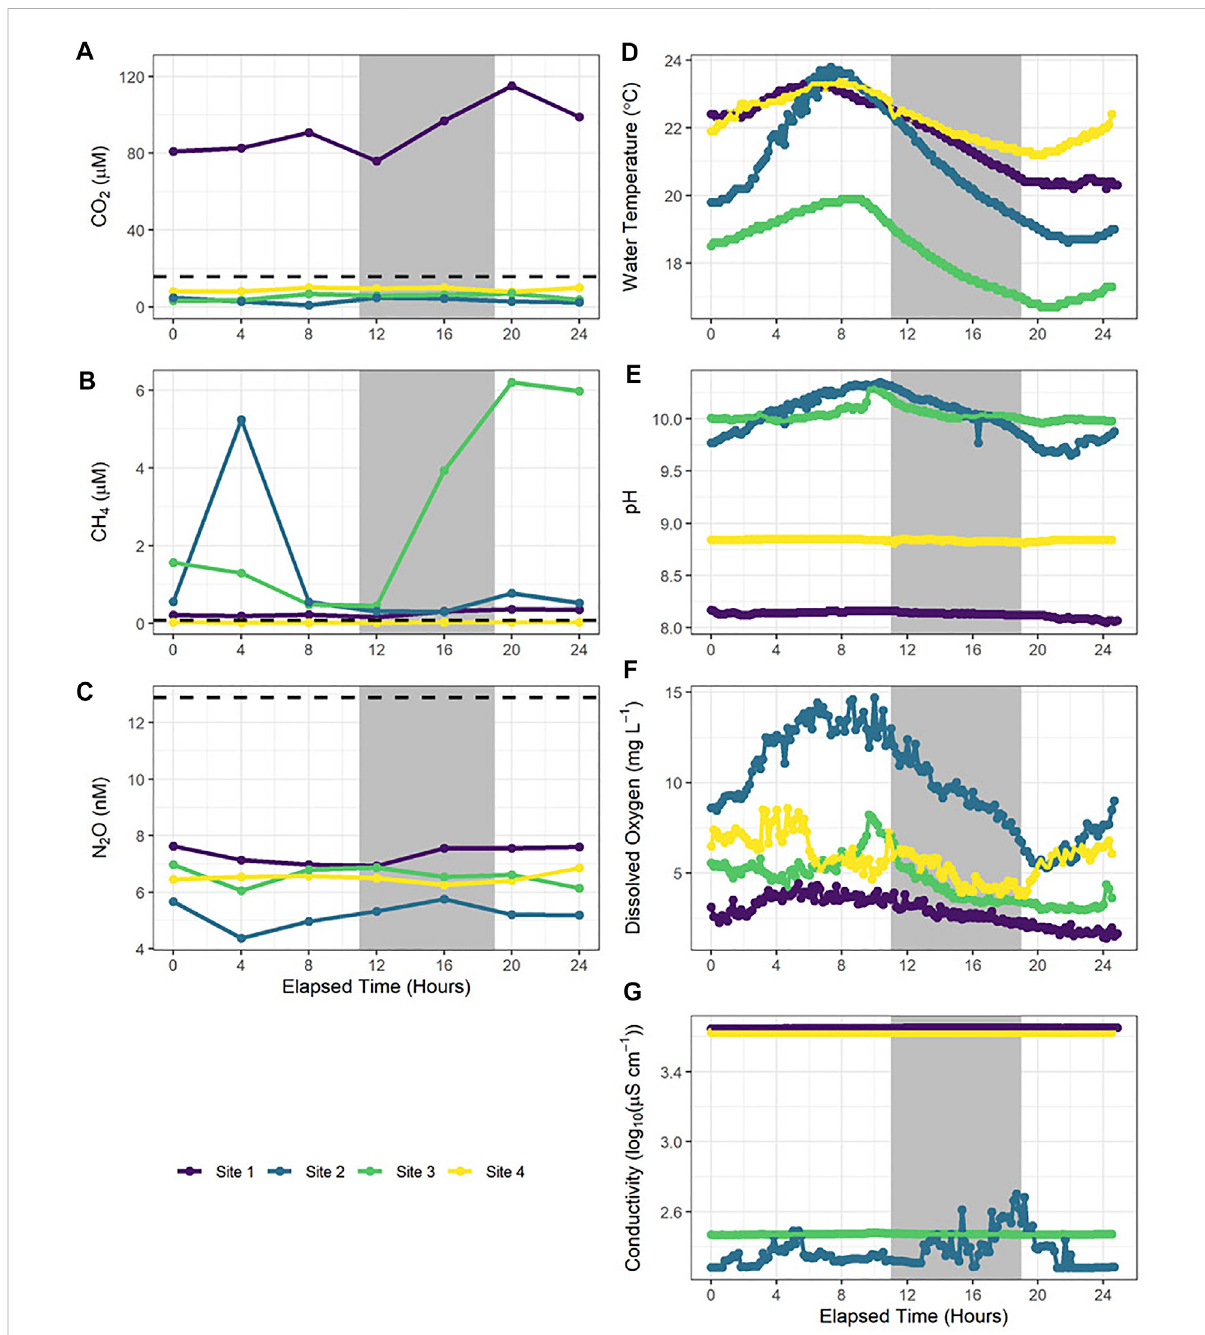
FIGURE 3 Greenhousegas (A – C) andwater qualityparameters (D – G) infourreservoirsmeasuredovera24-hperiod.Eachcolouredlineisrepresentative of one site. The grey shaded regions are the average night-time period. Elapsed time is time from the initiation of the 24-h period. Earliest start was 09:50, while the latest start was 11:24. Temperature (D) , DO (dissolved oxygen (E) ), pH (F) and conductivity (G) readings were taken every 10 min, whilegreenhousegasconcentrationswerecollectedevery4 h.CO 2 =carbondioxide (A) .CH 4 =methane (B) .N 2 O=nitrousoxide (C) .See24-h averages of nutrient, Chl- a and carbon concentrations in Supplementary Table